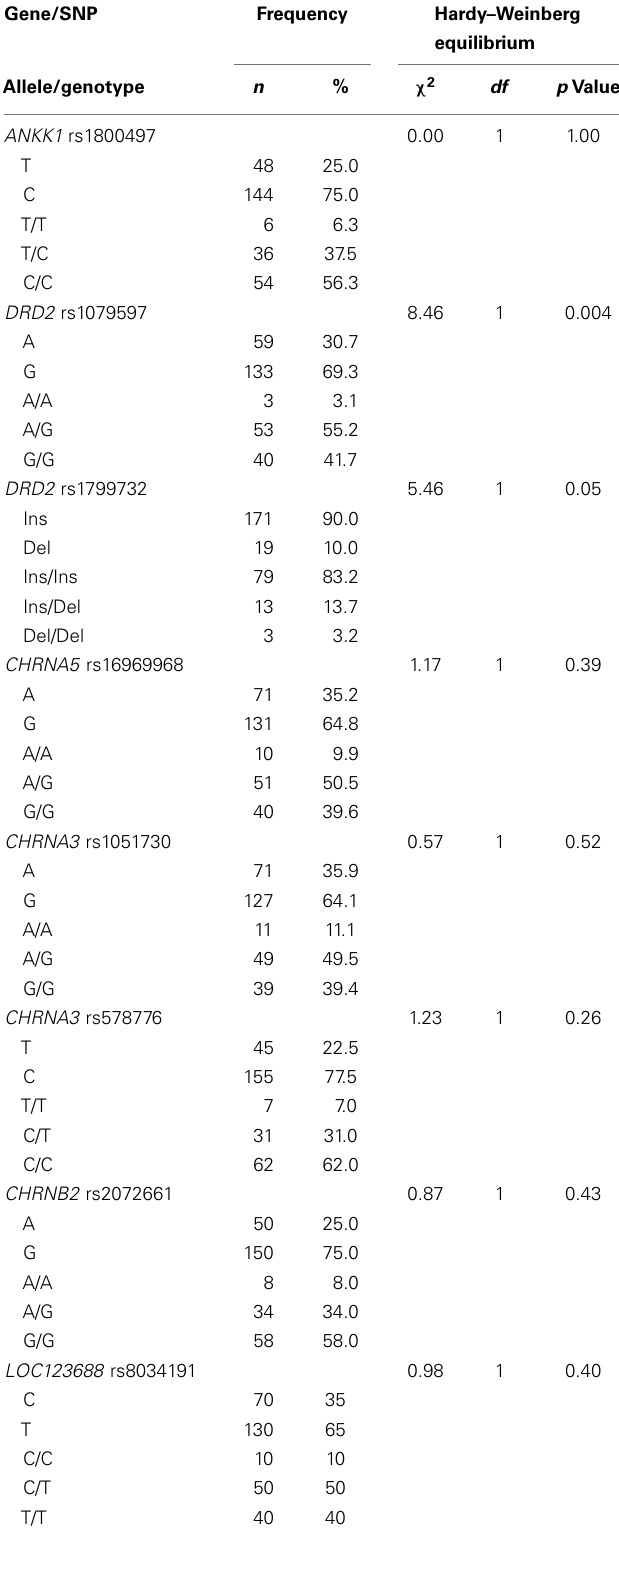
Table 2 |Tests of Hardy–Weinberg equilibrium and frequencies by allele and genotype for the participants of European